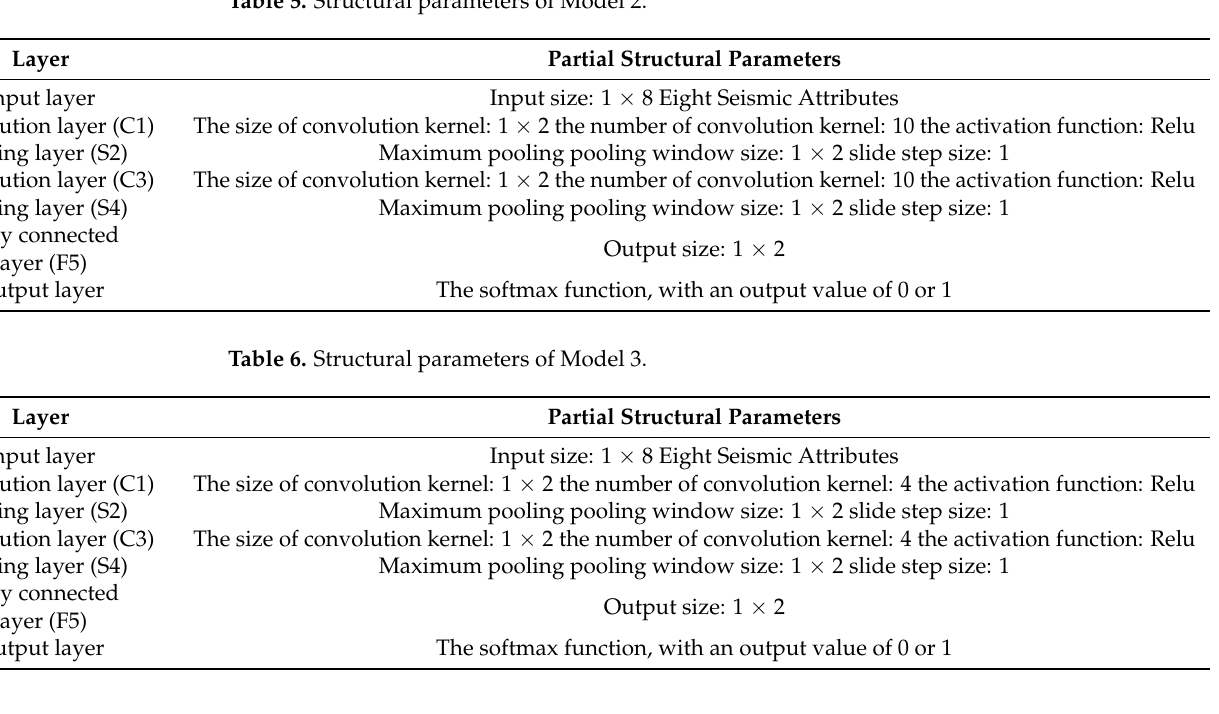
Table 5. Structural parameters of Model 2.